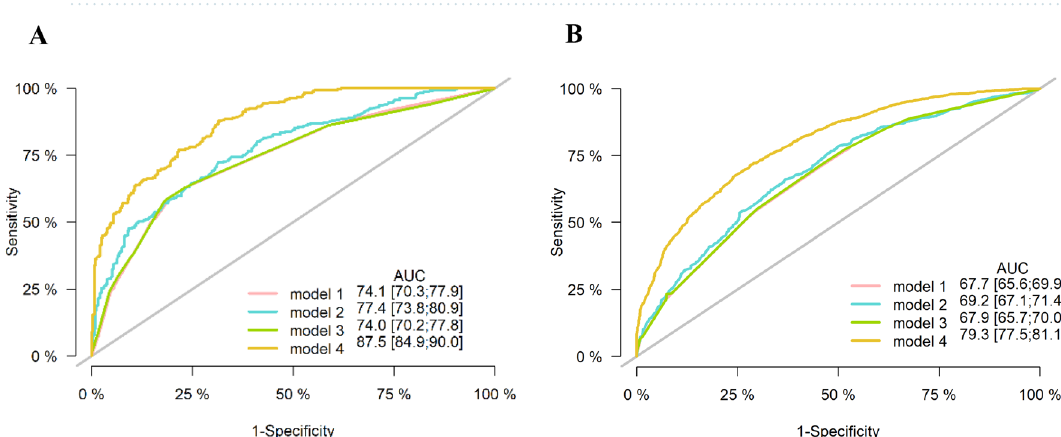
Figure 3. ROC curves of the prediction models. ( A ): Training cohort; ( B ): Testing cohort; model 1, Cox-TNM; model 2, Lasso-Cox; model 3, RSF-TNM; model 4,